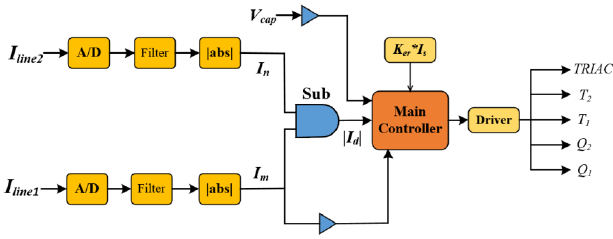
Figure 5. Diagram of differential protection control strategy.